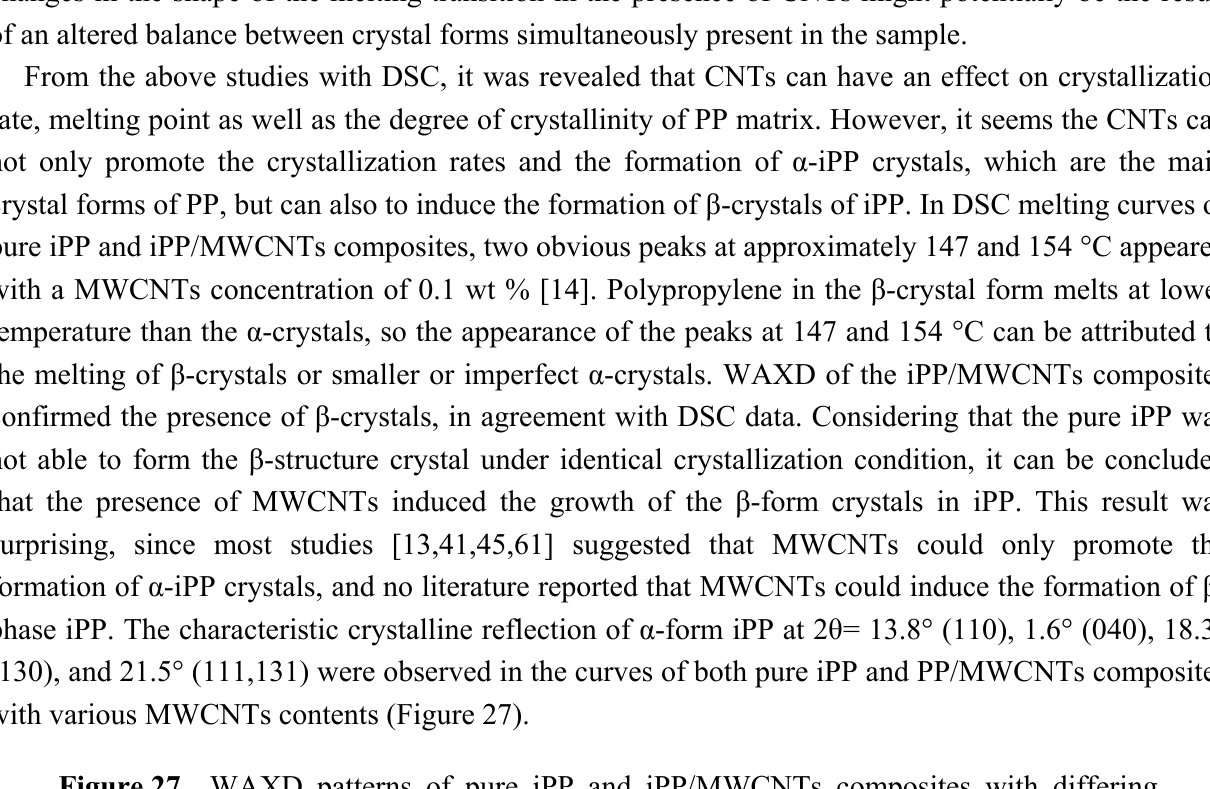
Figure 27. WAXD patterns of pure iPP and iPP/MWCNTs composites with differing MWCNTs contents. Reproduced with permission from ref.